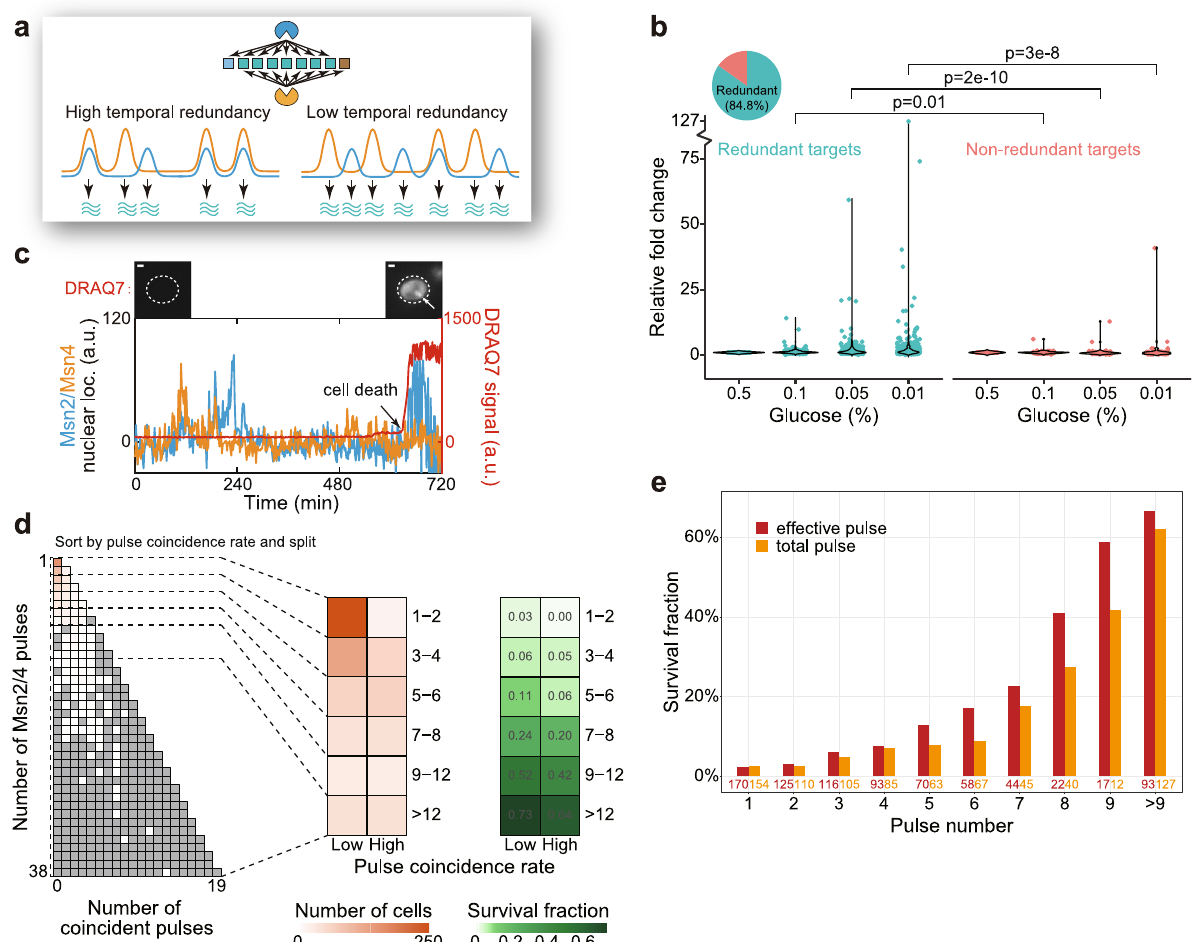
Fig. 3 Temporal redundancy modulation leads to increased dynamic ranges of target expression and can enhance stress survival capacity. a Schematics showing that cells could modulate temporal redundancy to control the expression of redundant target genes (cyan squares on the top). (Bottom) While pulse frequencies remain unchanged, the two TFs display a lower degree of temporal redundancy on the right, leading to more mRNA expression for the redundant targets (cyan squiggly lines). b Temporal redundancy modulation contributes to increased dynamic ranges of target genes. Steady-state gene expression levels under four different glucose limitation stresses are shown for both redundant and nonredundant targets of Msn2/ Msn4. Redundant targets show elevated activation fold changes compared to nonredundant targets at high stress conditions, presumably due to the decrease in temporal redundancy at high stress levels (Fig. 1c). Gene number is 436 and p values indicate one-sided Kolmogorov – Smirnov (K – S) test. c Single-cell assay to quantify the physiological effect of temporal redundancy modulation on yeast stress survival. In this example cell (out of 1676 cells), Msn2 (blue) and Msn4 (orange) nuclear localization dynamics, together with the signal from a live-dead reporter DRAQ7 (red), were recorded under glucose limitation stress (0.05% glucose). Scale bars indicate 1 μ m. See also Supplementary Movie 2. d Quantifying the effect of temporal redundancy modulation on stress survival. Cells were grouped based on similar total Msn2/4 pulse numbers during the fi rst 7-h movie under glucose limitation stress (0.05% glucose) and within each group, cells were divided into two subgroups based on the pulse coincidence rate in each cell (see “ Methods ” for details). Note that cells were binned to increase the cell number for the calculation of survival fraction. Survival fraction after 6 more hours for each subgroup was then calculated. Eight hundred and eight cells that survived >7 h (out of 1676 cells) were analyzed in this fi gure. e Survival fractions for cells with varying numbers of effective or total Msn2/4 pulses. Cells in ( d ) were grouped based on the number of effective pulses or total Msn2/4 pulses, and the survival fraction of each group was calculated. Cell numbers are indicated in the